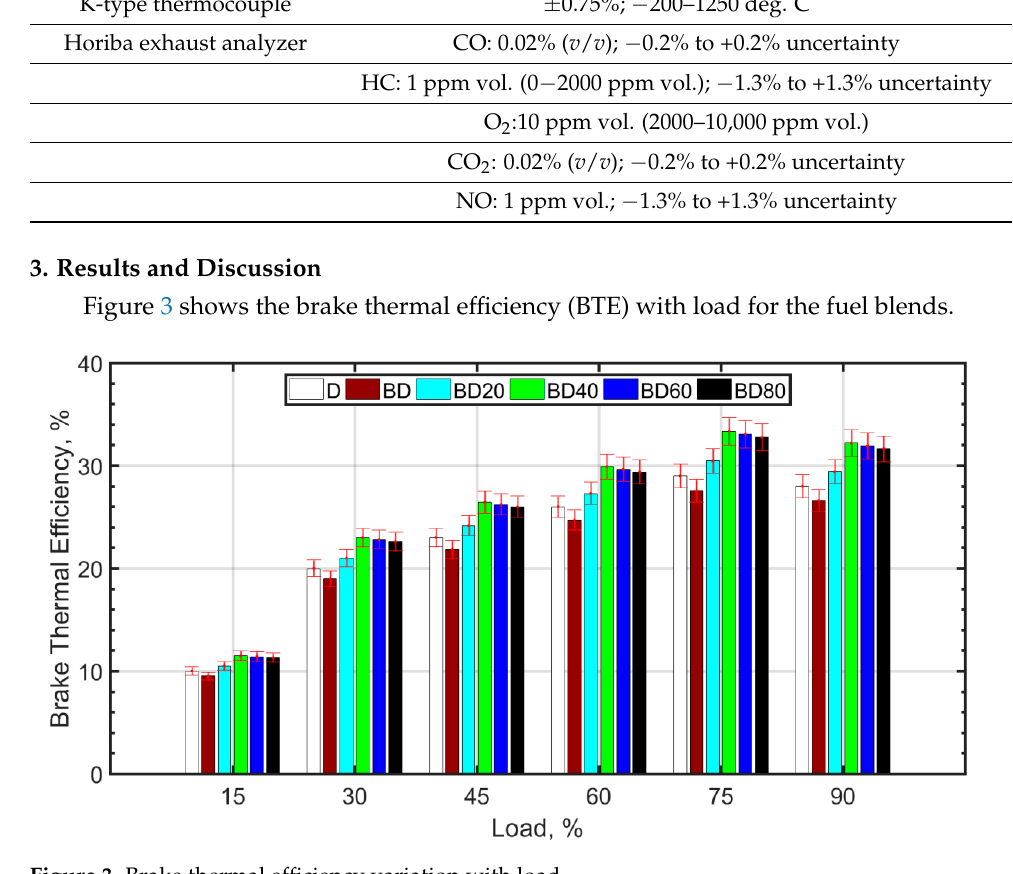
Figure 3. Brake thermal efficiency variation with load.